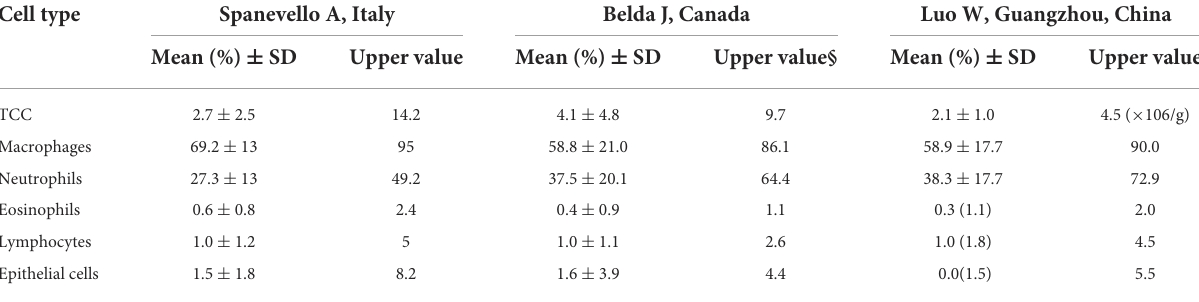
TABLE 2 Reference values of sputum inflammatory cells in healthy subjects. Cell